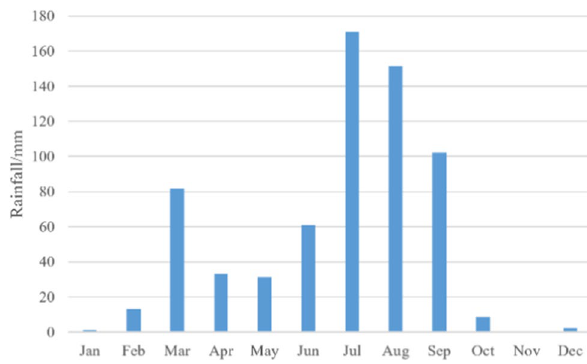
Fig. 1 Average rainfall in